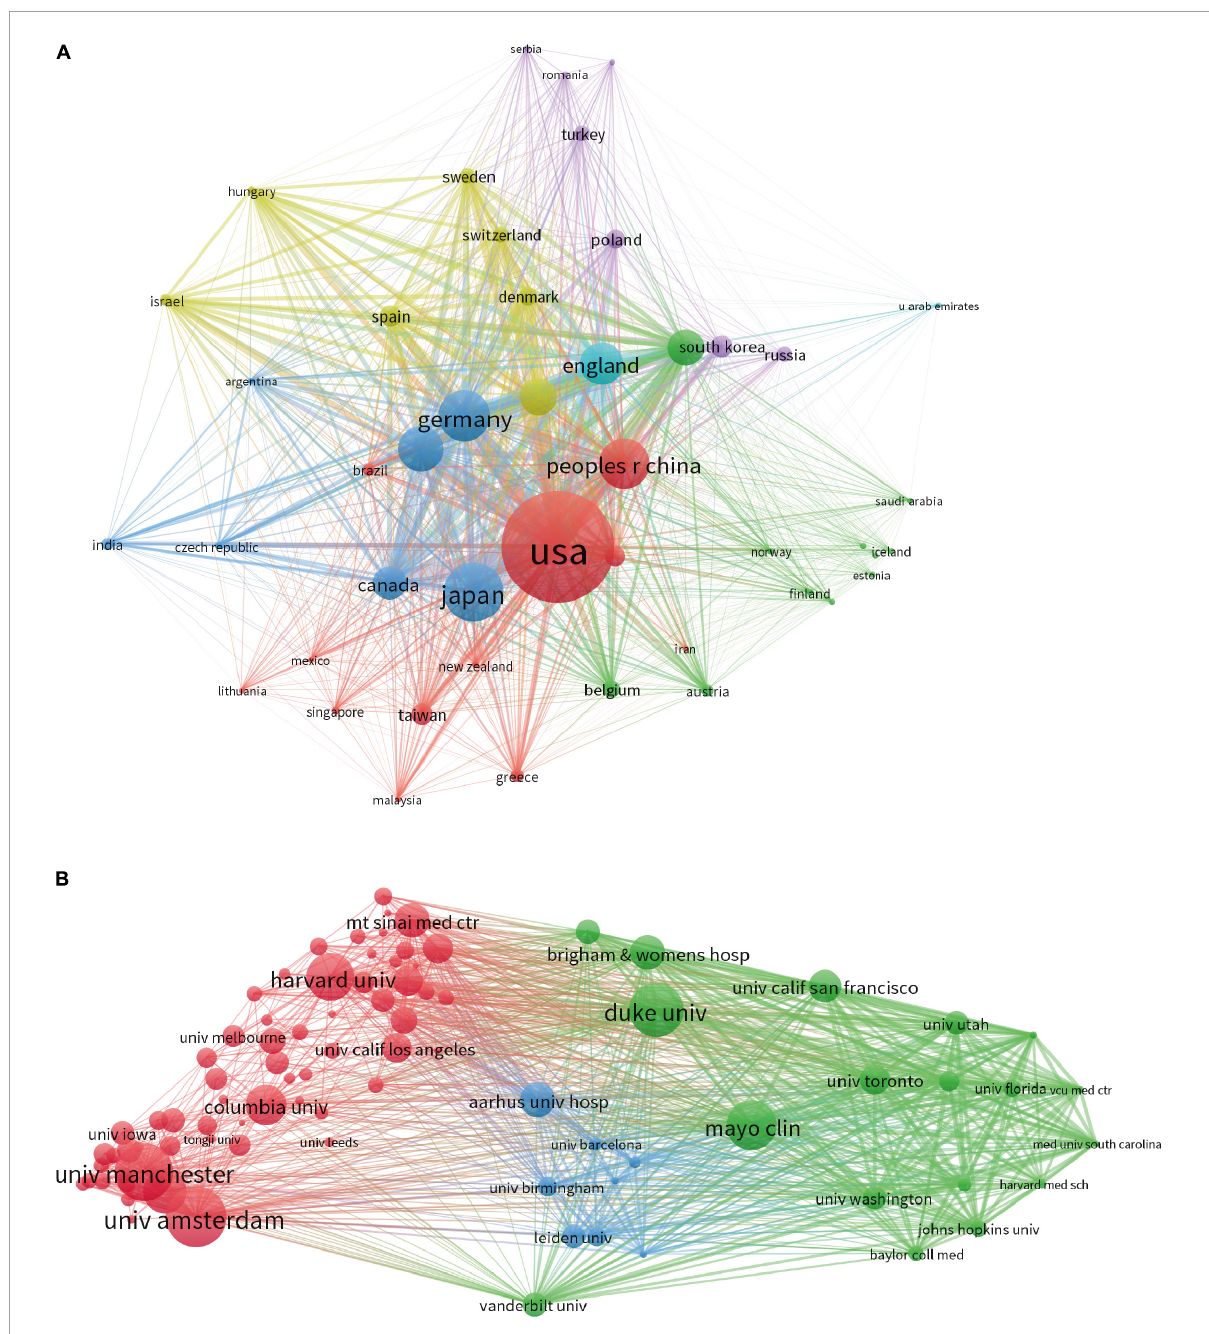
FIGURE2 (A) Network map of Country/Region analysis based on VOS viewer. (B) Network map of Institutions analysis based on VOS